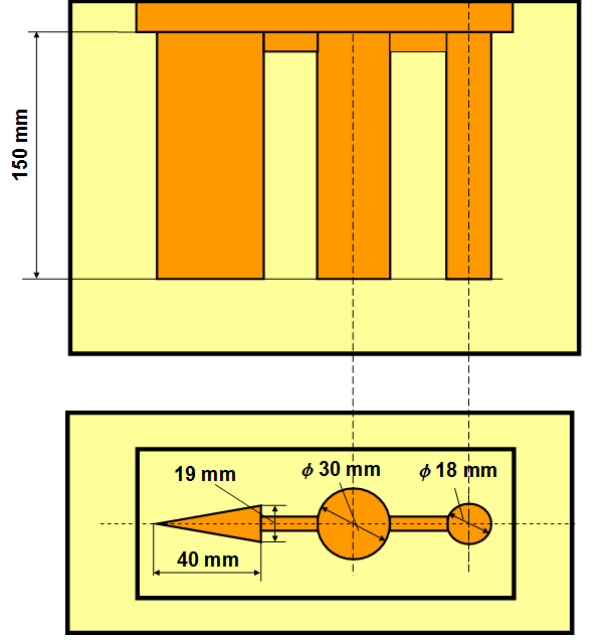
Figure 6. Mold for casting bars and